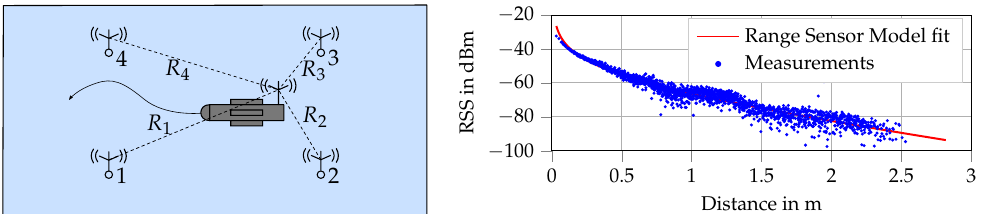
Figure 9. EM-localisation concept with four emitting anchor nodes and a receiver onboard an UUV ( left ) and range sensor model fit from calibration measurements ( right